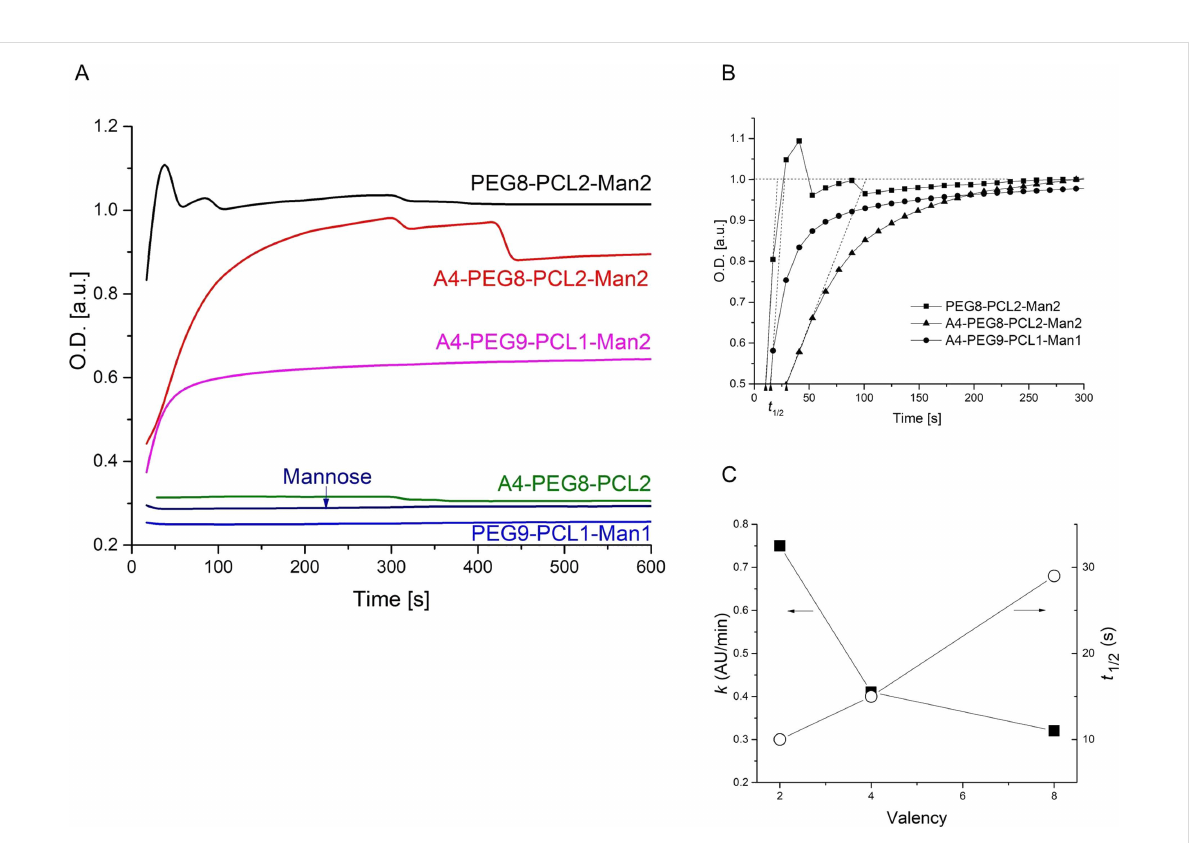
Figure 7: Turbidimetric assay results. A) Optical density (OD) data were recorded at 420 nm every 12 s for 10 min. B) t 1/2 was calculated as the time to reach half (OD= 0.5 a.u.) of the maximum optical density in normalized OD curve. The initial slope of the OD curve was used to determine the initial aggregation rate k . C) k (AU/min) and t 1/2 plotted as function of mannose valency.